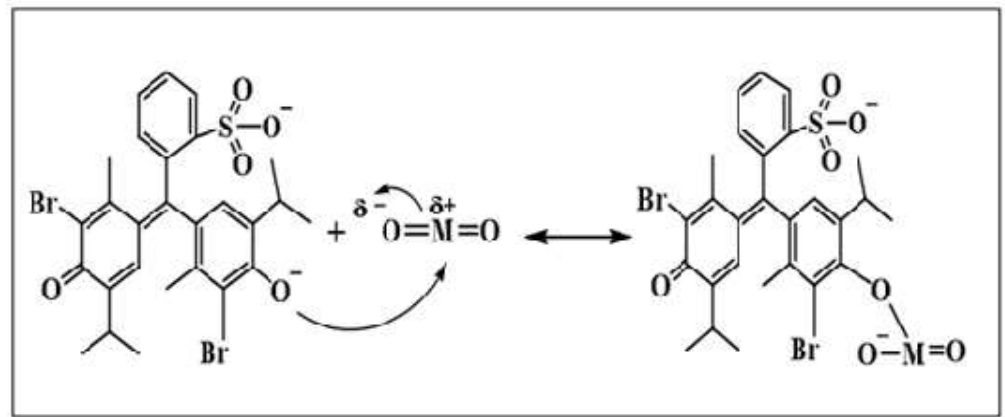
Figure (11): The suggested mechanisms to remove bromothymol blue (BTB) by nanoparticles. According to these mechanisms, MB can bond with nanoparticles from two sides (sulphur and nitrogen), while BTB can bond with nanoparticles only by one side (phenoxide). Therefore, we can conclude why the removal